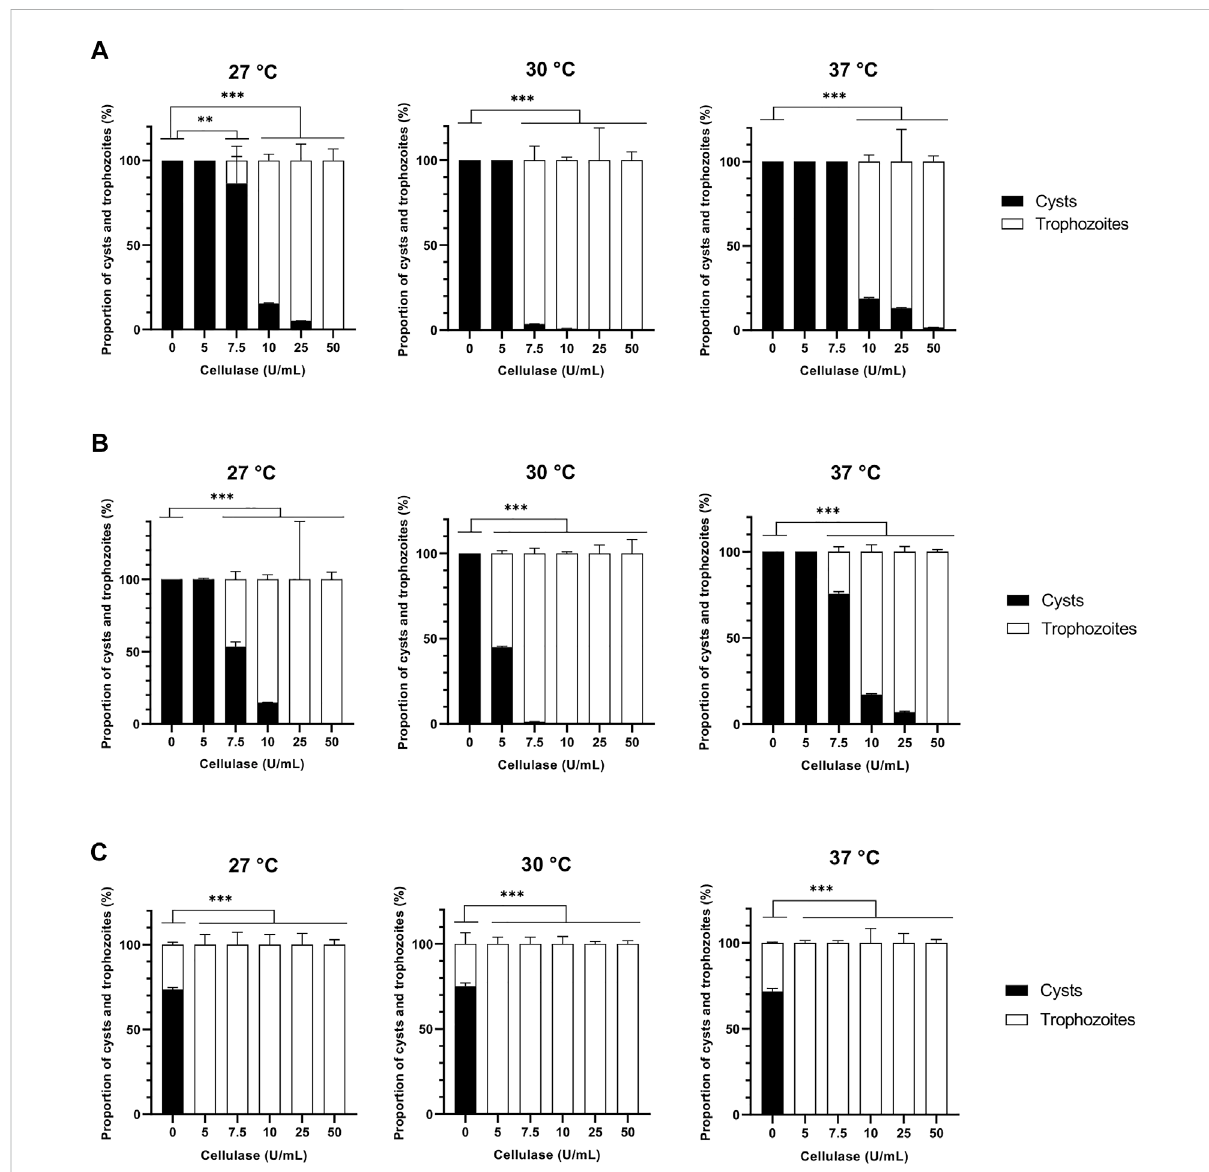
FIGURE 1 Effect of cellulase on Acanthamoeba castellanii excystment. Proportions of A. castellanii trophozoites and cysts observed following 24 h (A) , 48 h (B) and 72 h (C) of cellulase treatment at 27, 30 and 37 ° C as a function of enzyme concentration. The results correspond to the mean of four independent experiments